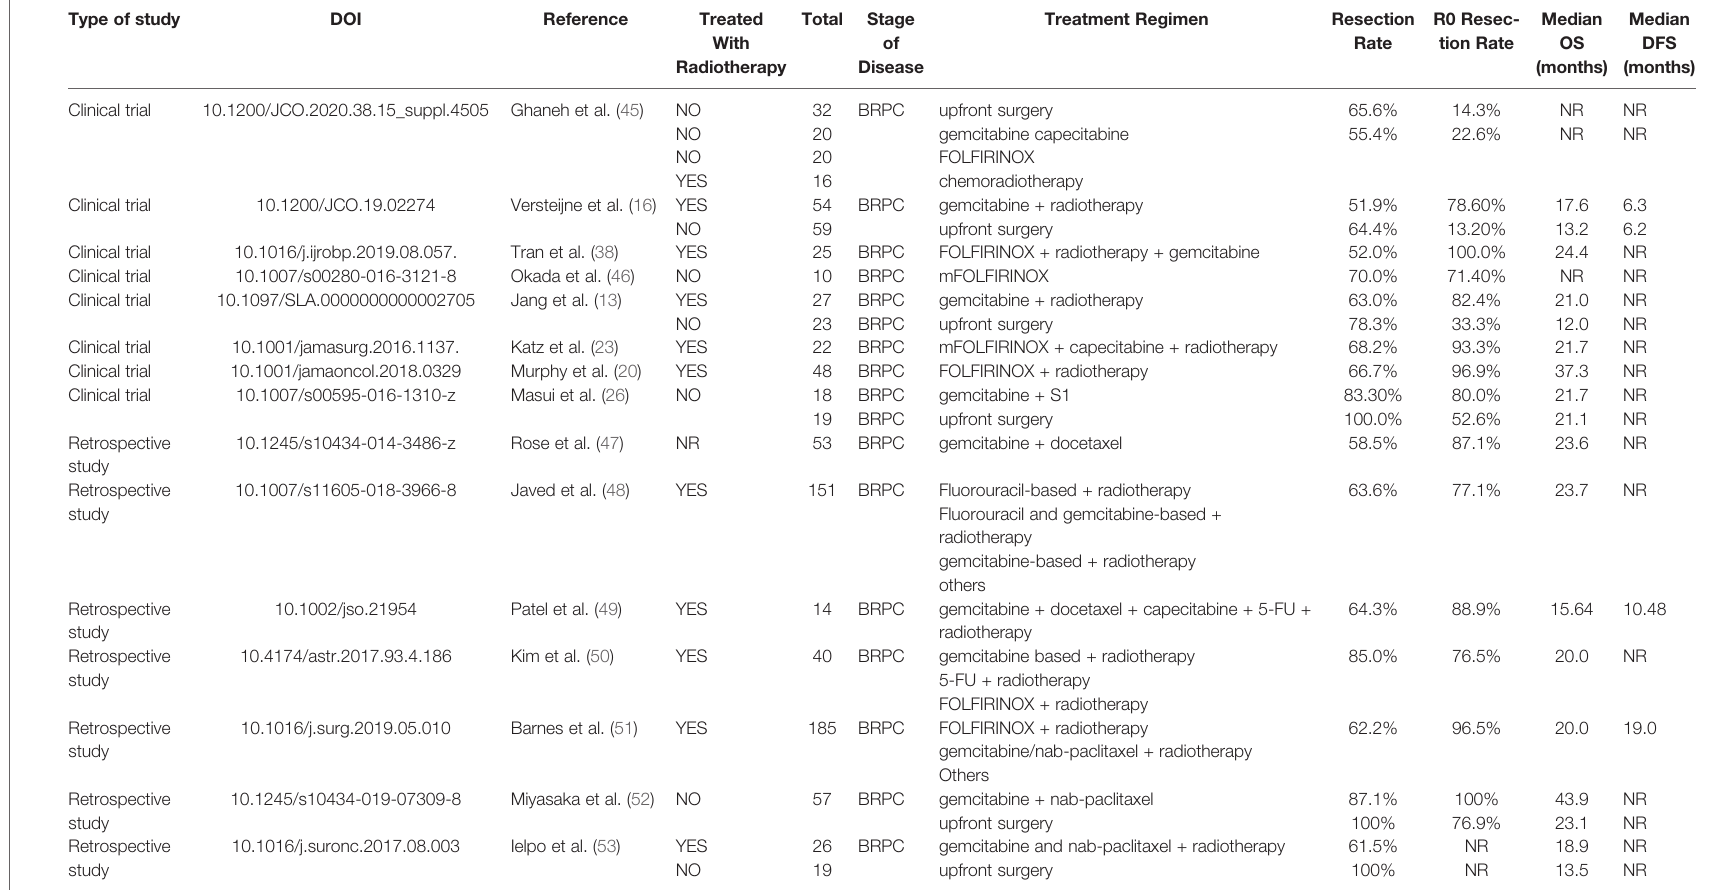
BRPC, borderline resectable pancreatic cancer; FOLFIRINOX, oxaliplatin, irinotecan, fl uorouracil, and leucovorin; mFOLFIRINOX, modi fi ed FOLFIRINOX; OS, overall survival; DFS, disease-free survival; NR, not